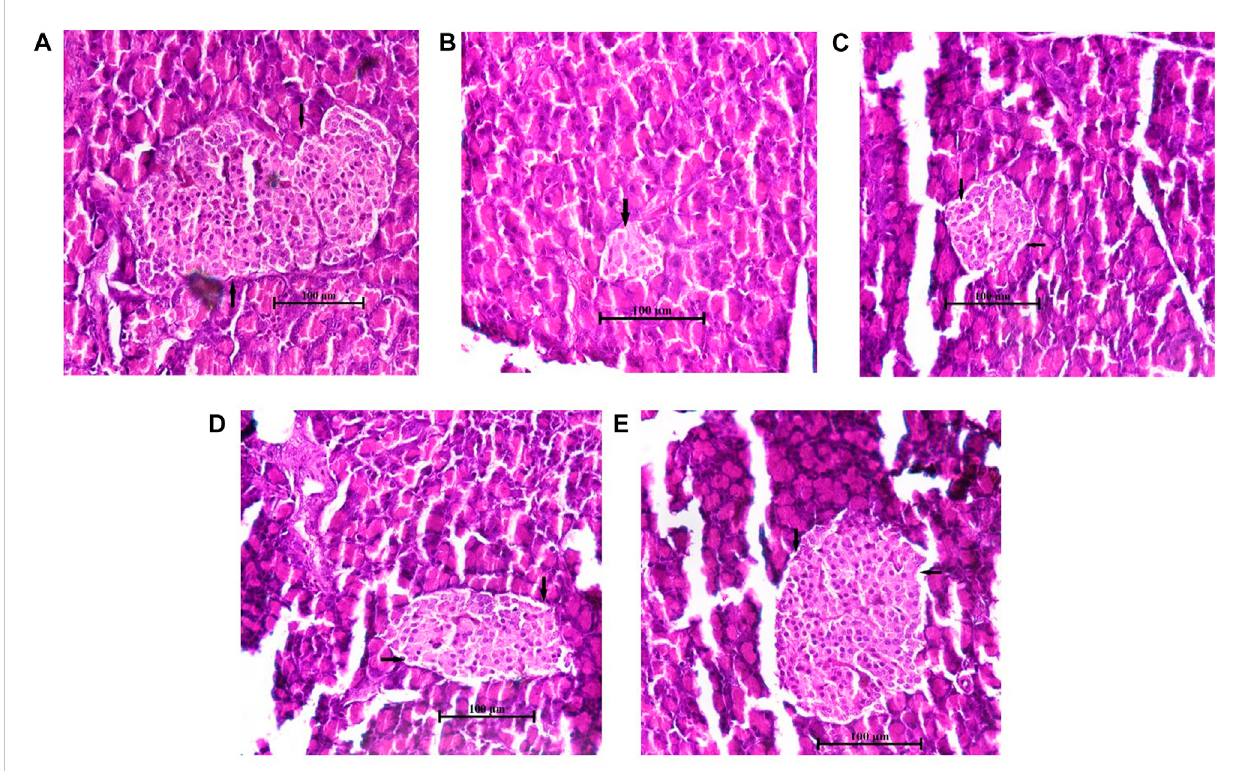
FIGURE 8 Histopathological features of the pancreatic islets of normal and STZ – NA-induced diabetic Wistar albino rats. (A) Normal control group depicting the normal histology of the pancreas, (B) diabetic pancreas showing a depleted, distorted β -cell structure and greatly reduced islets size, (C) diabetic + AAHY extract 200 mg/kg b.w.-treated pancreas showing mild improvement, (D) diabetic + AAHY extract 400 mg/kg b.w.-treated pancreas revealing gradual regeneration of β -cells, thereby improving islets size, and (E) diabetic + metformin 150 mg/kg b.w.-treated pancreas showing the nearly normal structure of the islets. A representative photomicrograph of each group is shown ( n = 6). Scale bar = 100 µm.